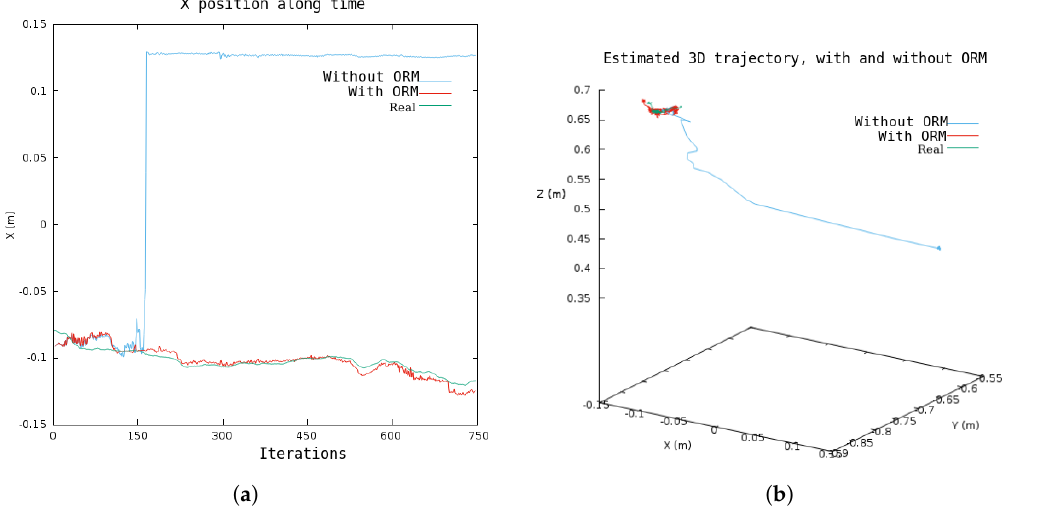
Figure 8. Estimated position and ground truth in sequence F3W with dynamic elements.